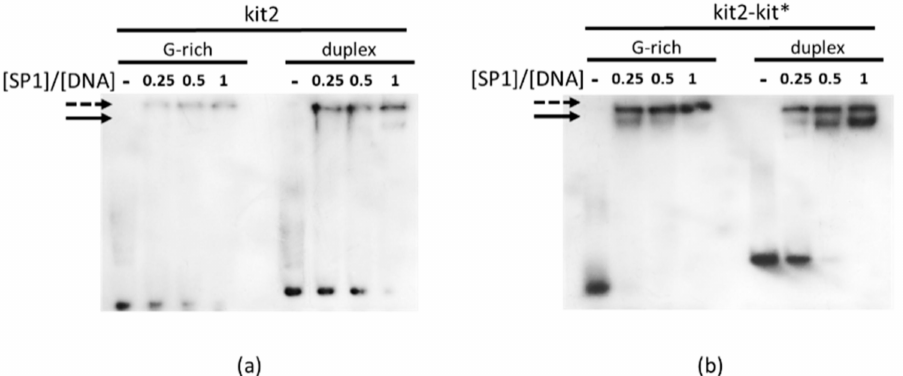
Figure 6. EMSA of 100 nM kit2 ( a ) and kit2-kit* ( b ) in the presence of 0.25, 0.5 or 1 eq of SP1. Lanes labelled—refer to samples in the absence of the protein; solid arrows point to DNA-protein complexes, the dotted one to not solved high molecular weight species.